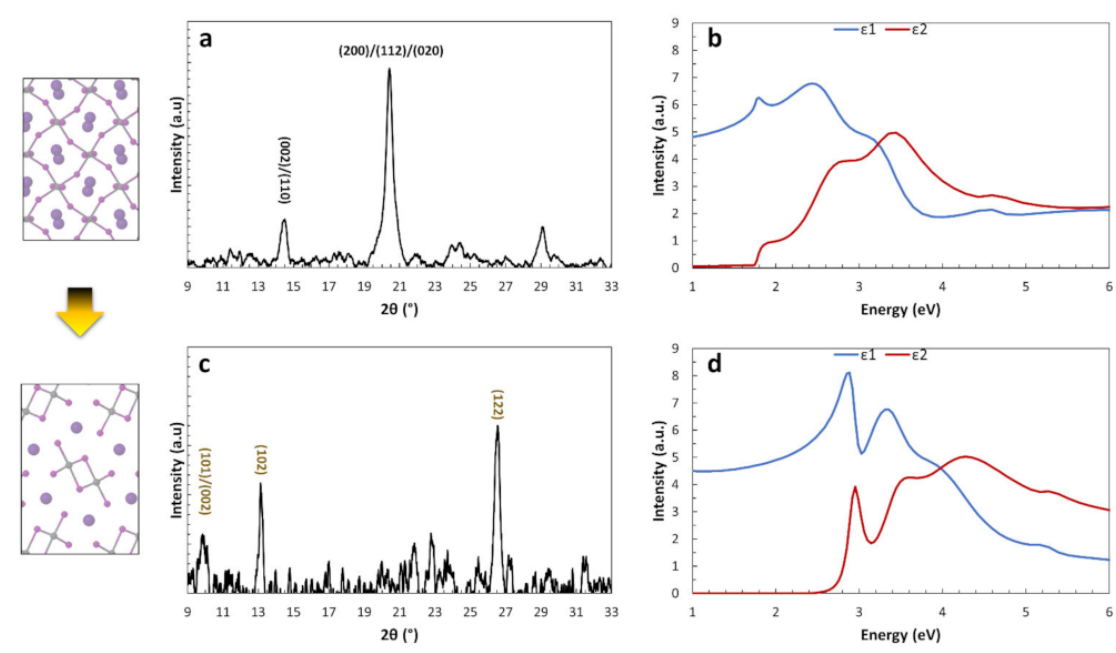
Figure 2. Structural and optical properties of the γ -CsPbI 3 perovskite phase and its transition towards the δ -CsPbI 3 yellow phase at room temperature: ( a ) XRD spectrum of the γ -CsPbI 3 phase; ( b ) Real ( ε 1 ) and imaginary ( ε 2 ) parts of the dielectric function for the γ -CsPbI 3 phase; ( c ) XRD spectrum of the δ -CsPbI 3 yellow phase; ( d ) Real ( ε 1 ) and imaginary ( ε 2 ) parts of the dielectric function for the δ -CsPbI 3 yellow